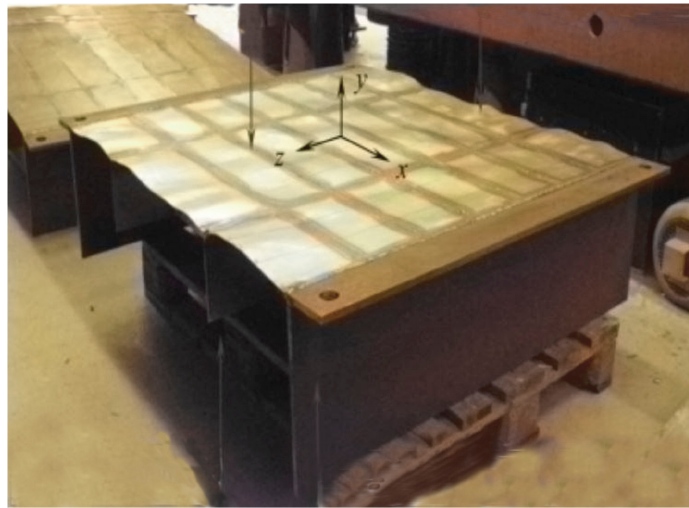
Figure 14. Photographs of the drop test experiment.